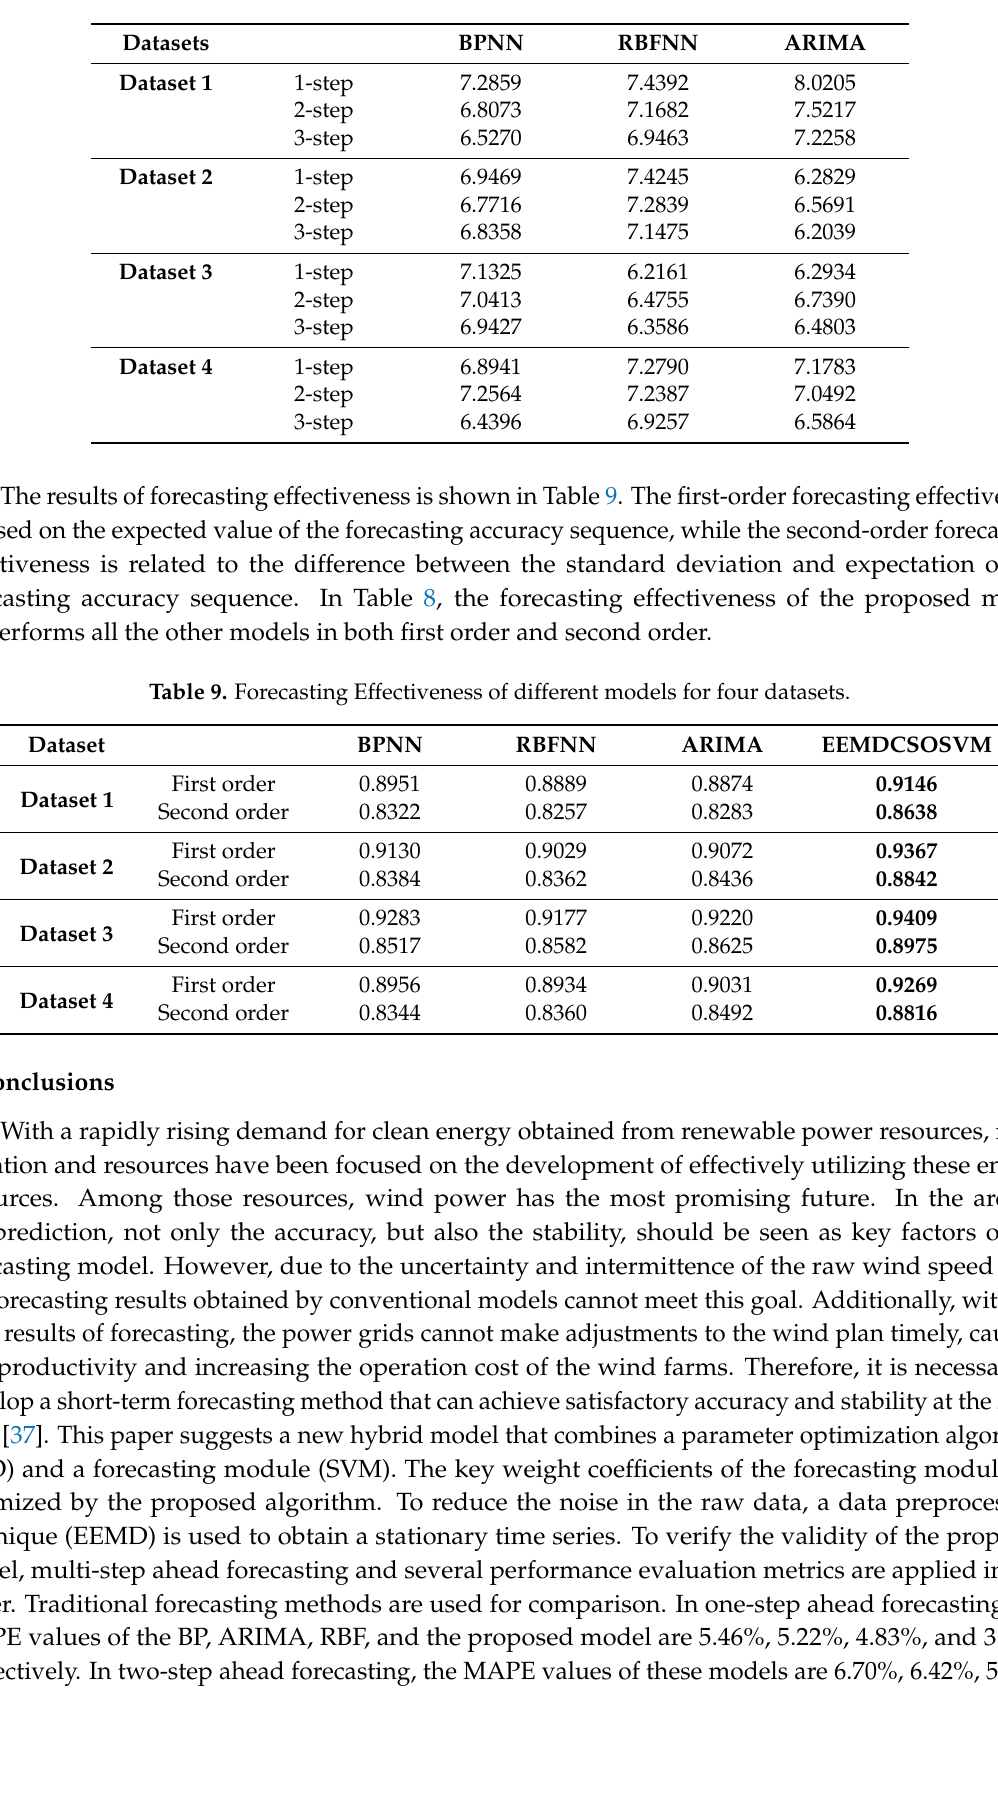
Table 8. Results of DM test.